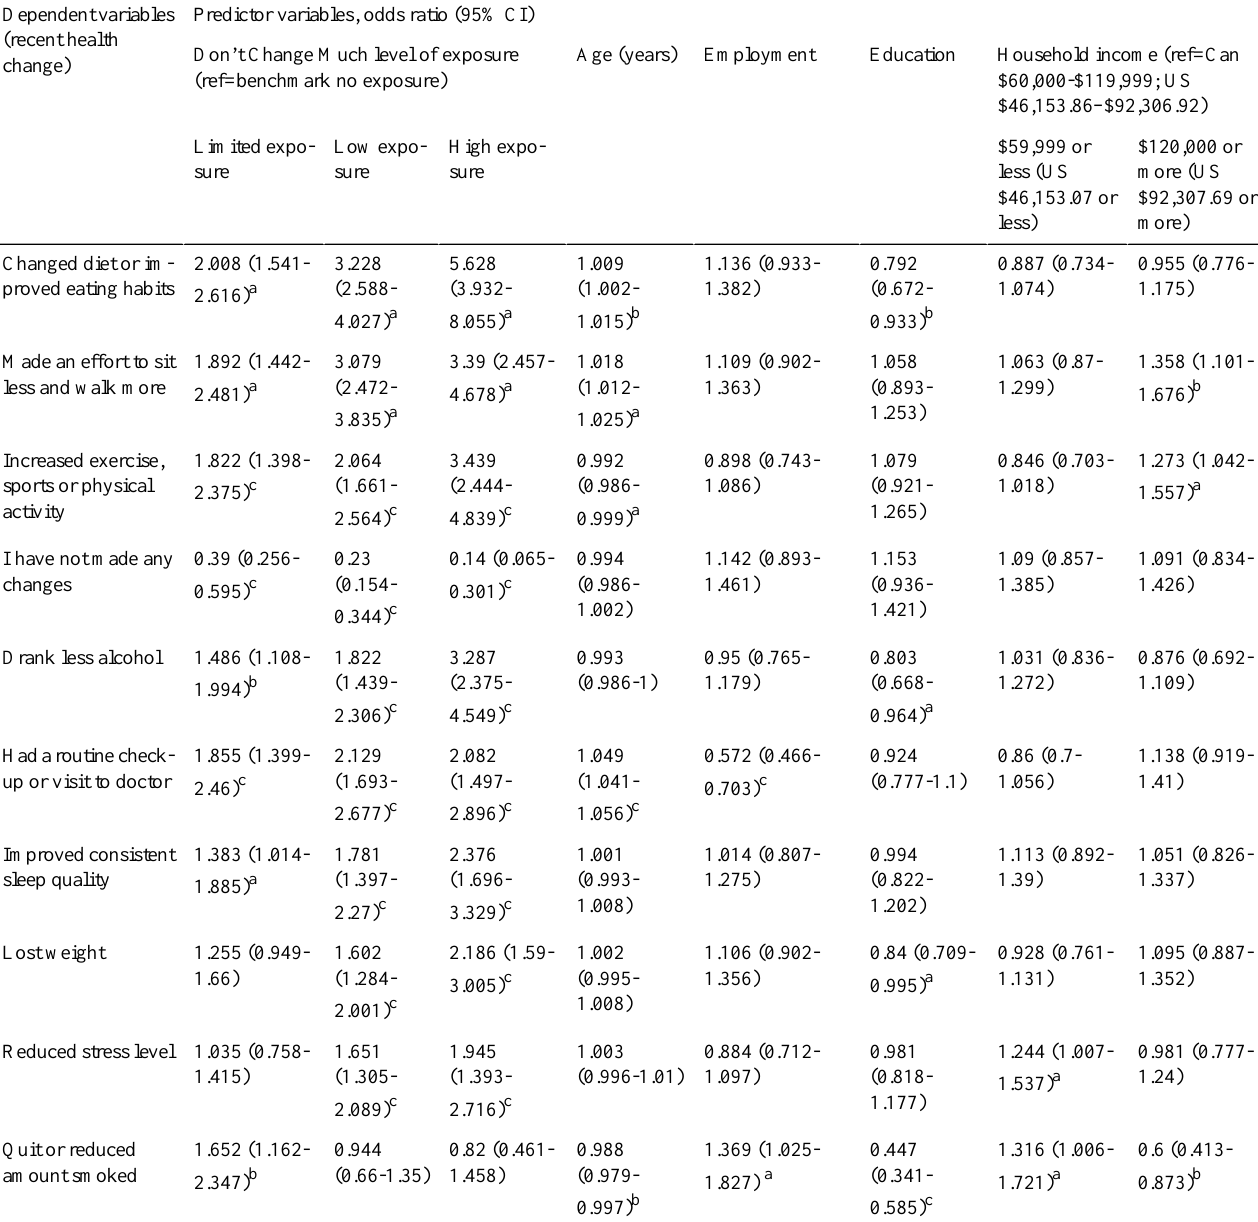
Table 2. Logistic regressions between statistically significant demographics and recent health changes (separate multiple logistic regressions were conducted for each outcome variable with all predictor variables entered on the same